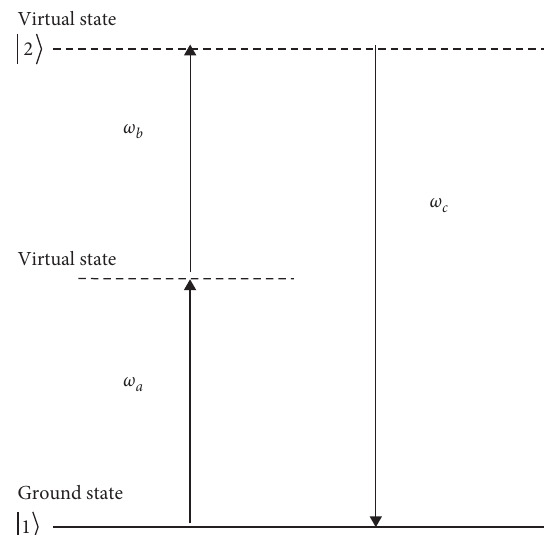
Figure 1: Energy level diagram of the frequency upconversion